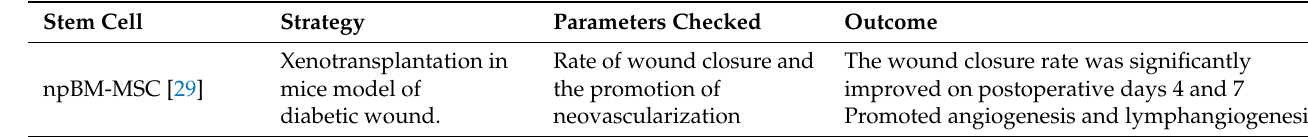
Table 2. Stem cells enhance angiogenesis and wound healing in DFUs. Neonatal porcine bone marrow-derived mesenchymal stem cell (npBM-MSC), Adipose-derived mesenchymal stem cells (ADSCs), human induced pluripotent stem cell-derived smooth muscle cells (hiPSCSMC), endothelial differentiated adipose-derived stem cells (EC-ADSCs), human umbilical cord blood-derived CD34 + stem cells (UCB-CD34 + SC), bone marrow mononuclear cells (BMMNCs), endothelial progenitor cells, human fetal aorta-derived CD133 + progenitor cells and their conditioned medium (CD133 + CCM), human umbilical cord-derived MSCs